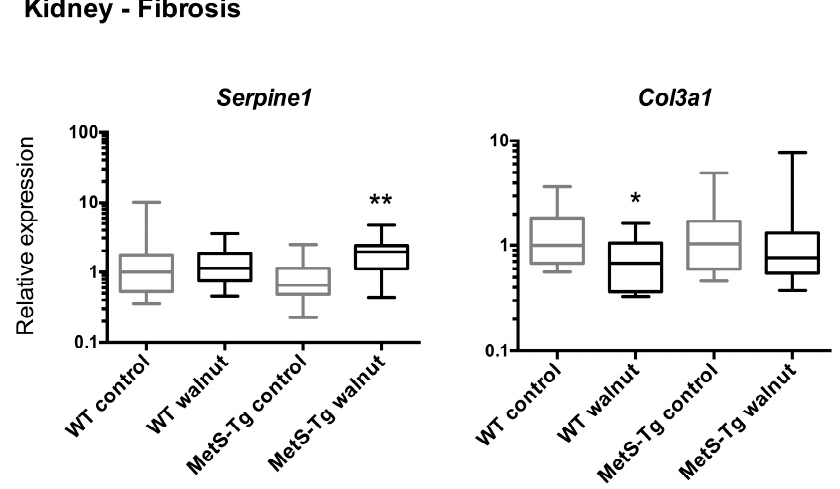
Figure 4. Relative levels of gene expression in kidney tissue for genes associated with fibrosis ( Serpine1 , Col2a1 ), shown as medians (Interquartile Ranges) with WT control expression set to 1, * p < 0.05, ** p < 0.005.